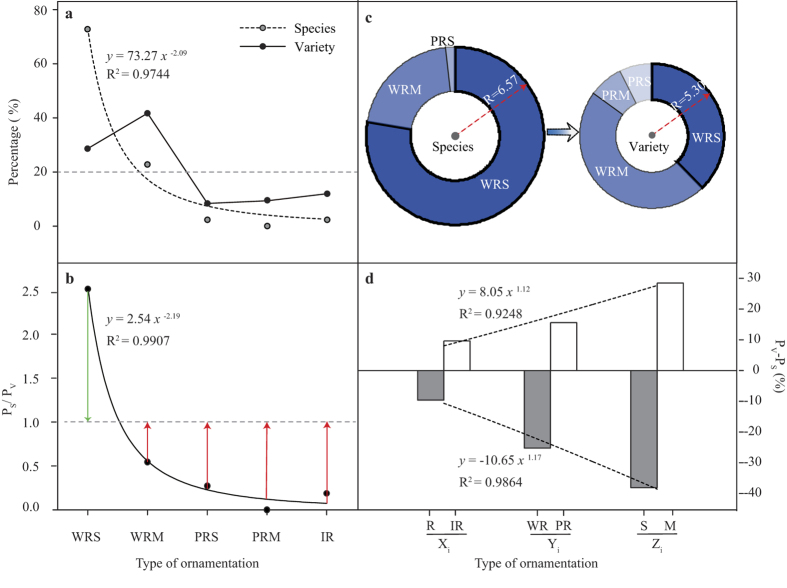
Comparison of pollen ornamentation regularities between species population and variety population of flowering crabapple.(a) The pollen ornamentation types’ constitution and weight distribution of species population and variety population of flowering crabapple. (b)The weighting ratio (PS/PV) distribution of ornamentation types in the two populations. Green column length (PS/PV − 1) stands for the relative weight (the weight of WRS type in species population exceeds that in variety population); red column length (1 − PS/PV) represents the relative weight (the weight of pollen types in variety population exceeds that in species population). (c) The average score of pollen ornamentation degree of regularity of two populations and the weight of score of each ornamentation type. The radius of circle presents the average score value; the pie chart presents the weight constitution of the ornamentation types scores of pollen germplasms. (d) Weight differential of pollen ornamentations of the two populations in three dimensional directions (Xi Yi Zi). PS, percentage of species quantity of each ornamentation type; PV, percentage of variety quantity of each ornamentation type. R, Regular Type; IR, Irregular Type; WR, Wholly Regular Type; PR, Partially Regular Type; S, Single-pattern Type; M, Multi-pattern Type.